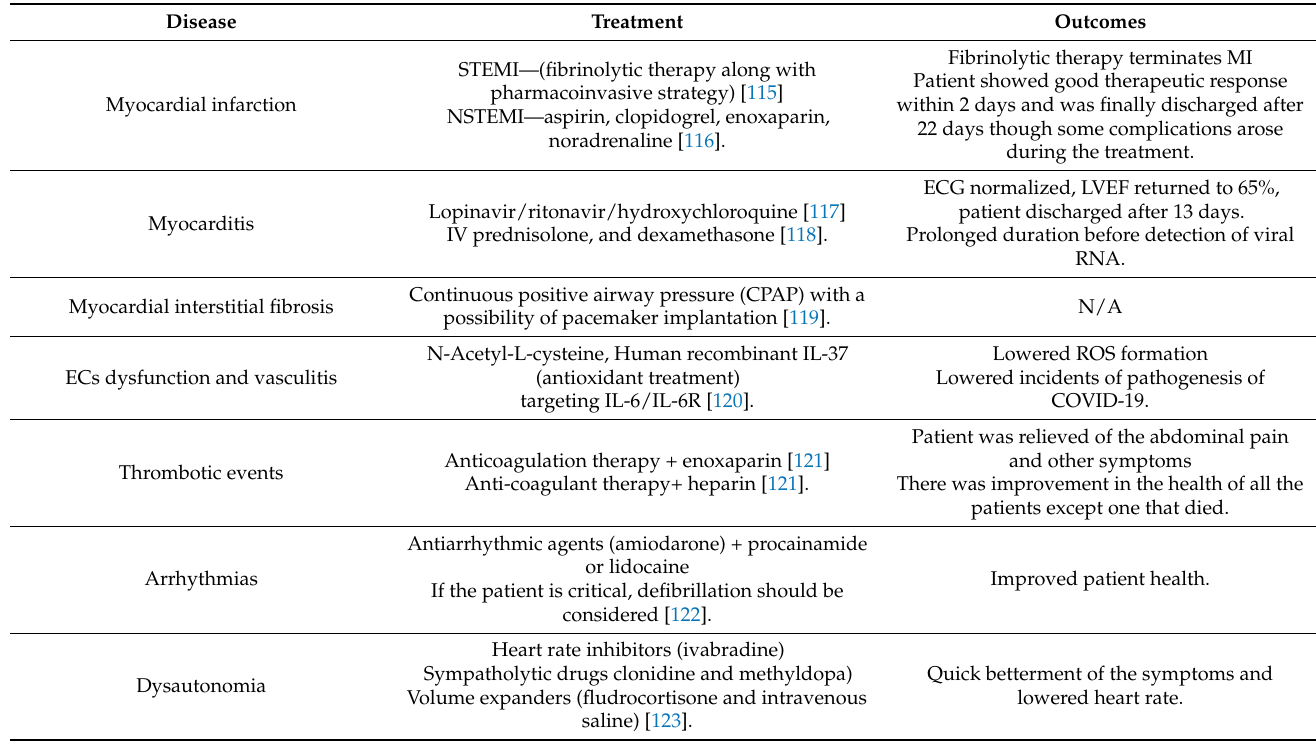
Table 2. Treatment consideration